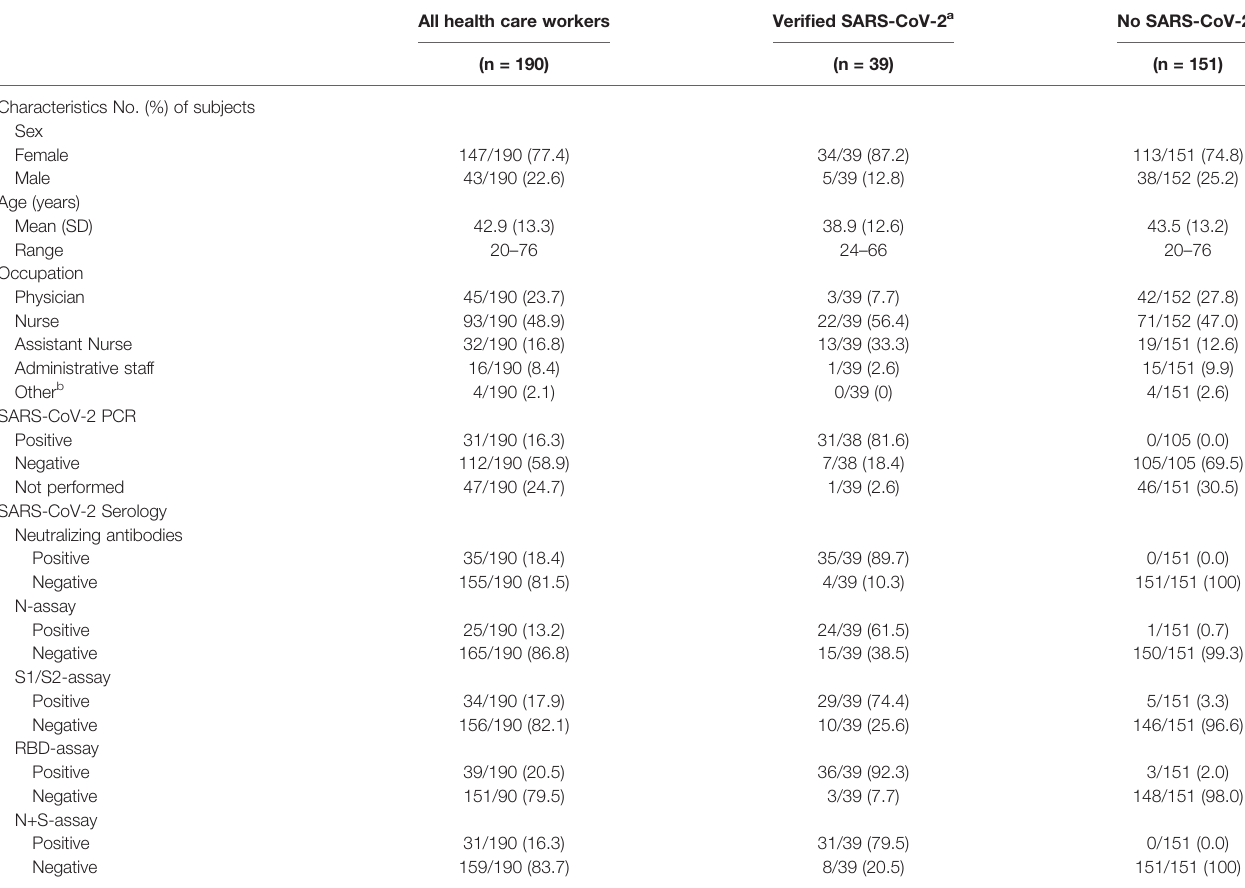
TABLE 2 | Characteristics of health care workers with and without veri fi ed SARS-CoV-2 infection at time-point 4 (21 th of September – 8 th of October 2020) and speci fi city and sensitivity of all SARS-CoV-2 speci fi c assays in time-point 4 (commercial IgG-assays, neutralizing antibodies and CD4 + speci fi c T cells). All health care